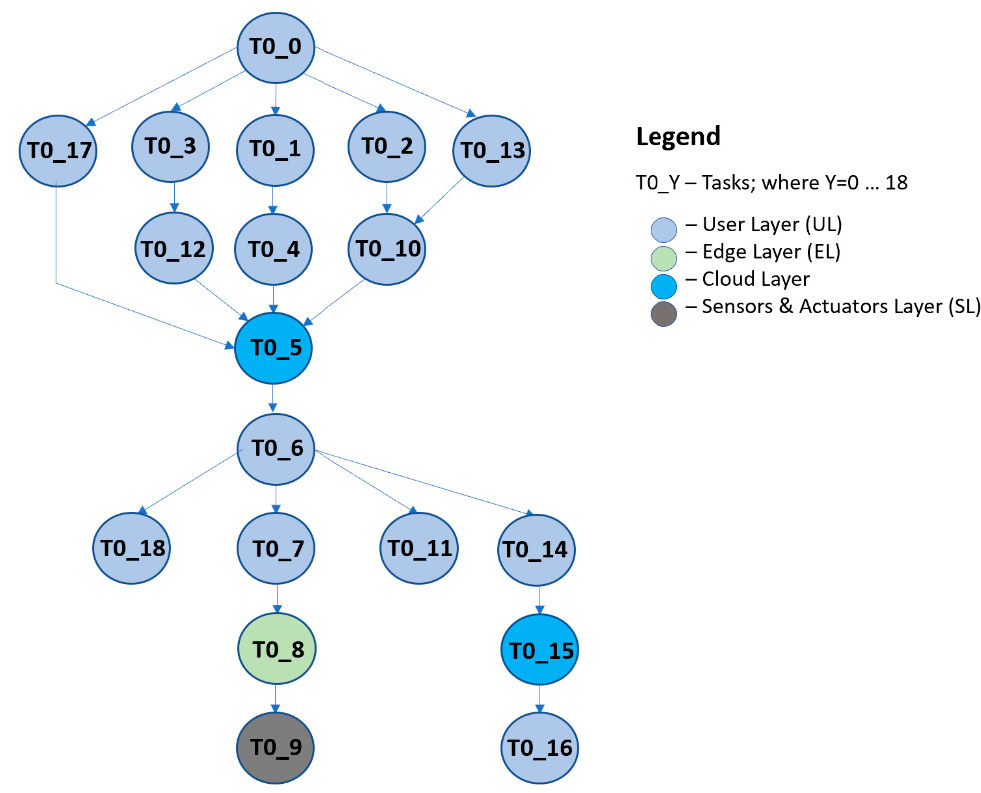
Figure 3. Task graph of the parking space management system.